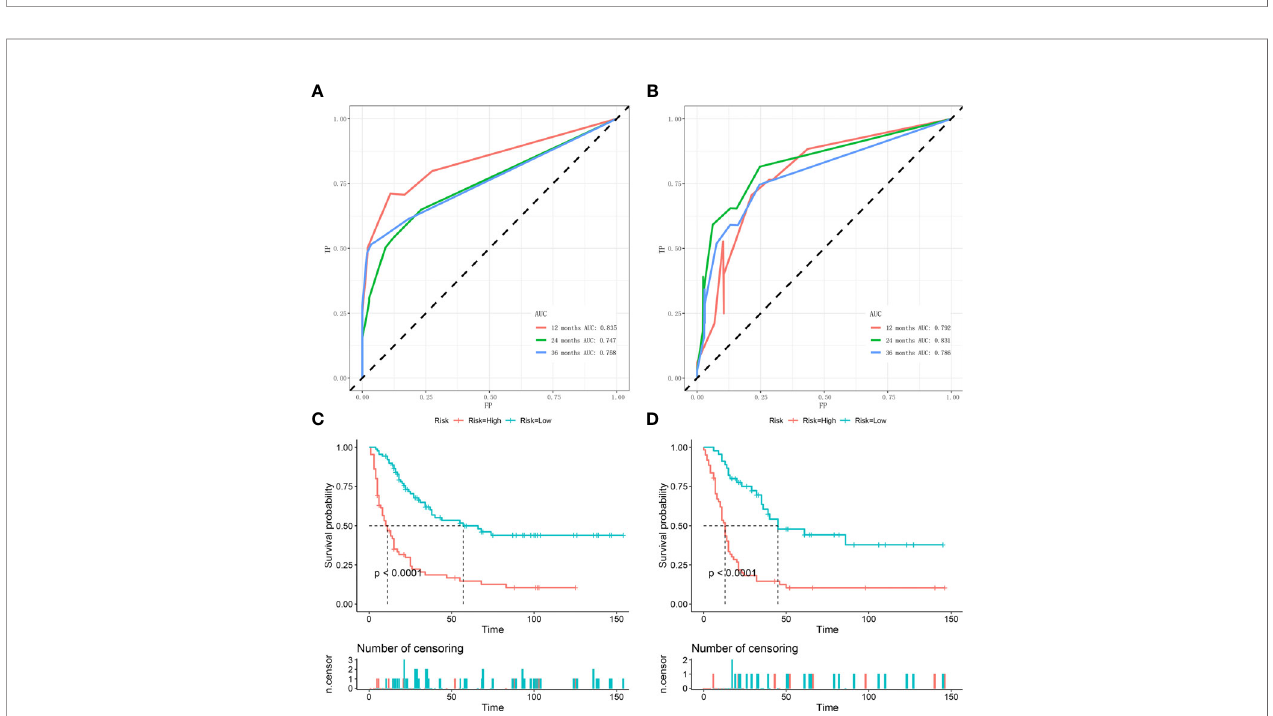
FIGURE 5 | The calibration curves of the nomogram for the 12 (A) , 24 (B) , and 36 months (C) in the validation set. The decision curve analysis of the nomogram for the 12 (D) , 24 (E) , and 36 months (F) in the validation